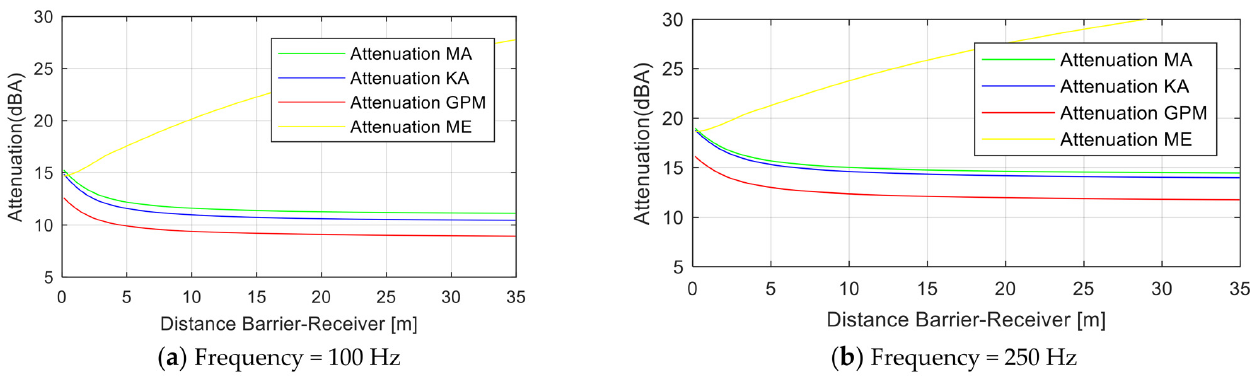
Figure 3. Sound attenuation as a function of the distance barrier-receiver and for a pure tone at 100 Hz ( a ) and 250 Hz ( b